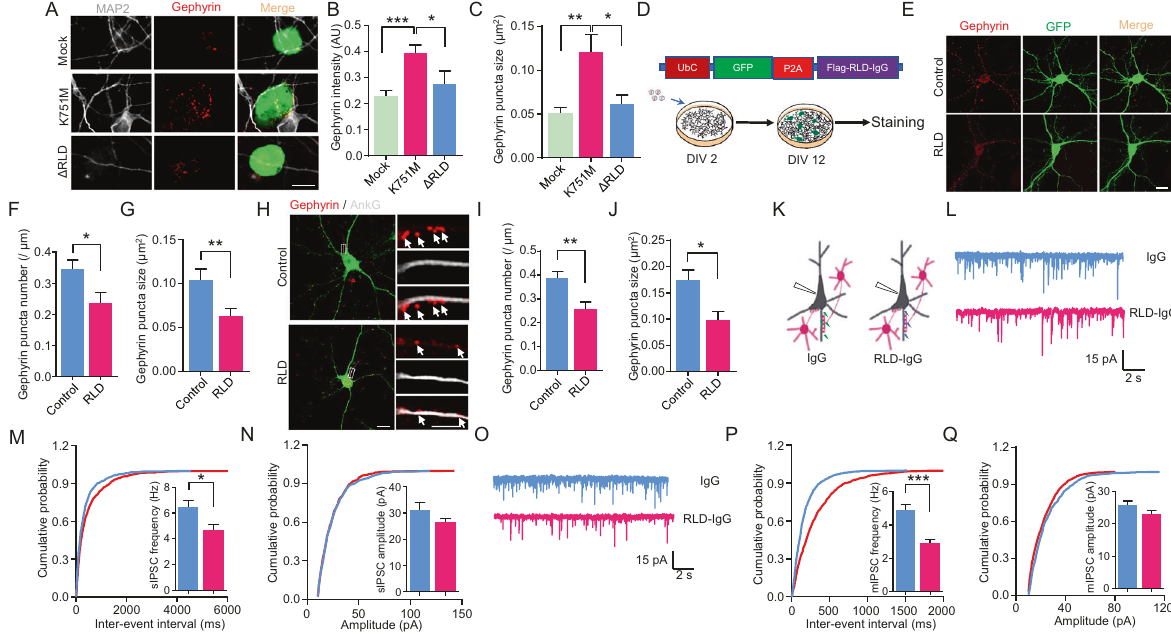
Fig. 5 ErbB4 – Slitrk3 interaction is important for inhibitory synapse formation and transmission. A – C ErbB4- Δ RLD-expressing HEK293T cells could not induce gephyrin puncta. HEK293T cells expressing K751M, Δ RLD, or empty vector (Mock) were co-cultured with hippocampal neurons (DIV9) and stained for MAP2 and gephyrin. Scale bar, 10 μ m ( A ). Quantitative analysis of the intensity ( B ) and size ( C ) of gephyrin puncta in A . n = 30 cells for Mock, n = 19 cells for K751M, and n = 23 cells for Δ RLD. D – G Perisomatic gephyrin puncta number and size were decreased in primary hippocampal neurons infected with RLD-expressing virus. Schematic of lentivirus vector expressing Flag-RLD- IgG and experimental timeline ( D ). Hippocampal neurons at DIV2 were infected with the virus expressing RLD or empty vector (Control) for 10 days and then fi xed and stained with gephyrin and GFP antibodies. Representative images of gephyrin + inhibitory synapses onto perisoma of cultured PyNs ( E ). Scale bar, 20 μ m. Quantitative analysis of perisomatic gephyrin puncta number ( F ) and size ( G ) in E . n = 30 neurons for Control, n = 30 neurons for RLD. H – J AIS gephyrin puncta number and size were decreased in primary hippocampal neurons infected with RLD-expressing virus. Representative images of gephyrin + AIS inhibitory synapses of cultured PyNs. Boxed areas were enlarged in the respective right images ( H ). Scale bar, 20 μ m for lower magni fi cation images and 10 μ m for enlarged images of boxed areas. Quantitative analysis of perisomatic gephyrin puncta number ( I ) and size ( J ) in H . n = 24 neurons for Control, n = 24 neurons for RLD. K – Q RLD injection decreased inhibitory synaptic transmission in hippocampal CA1 PyNs. Schematics of whole-cell patch-clamp recordings of PyNs in CA1 from IgG or RLD-IgG-injected K751M mice ( K ). Representative traces of sIPSCs ( L ) and mIPSCs ( O ). Scale bars, 15 pA, 2 s. Cumulative probability plots and histogram summary of sIPSCs and mIPSCs interevent intervals ( M , P ), as well as amplitudes ( N , Q ). n = 10 neurons from three IgG-injected mice and n = 9 neurons from three RLD-IgG-injected mice. Data were shown as mean ± SEM. * p < 0.05, ** p < 0.01, *** p < 0.001. Student ’ s t